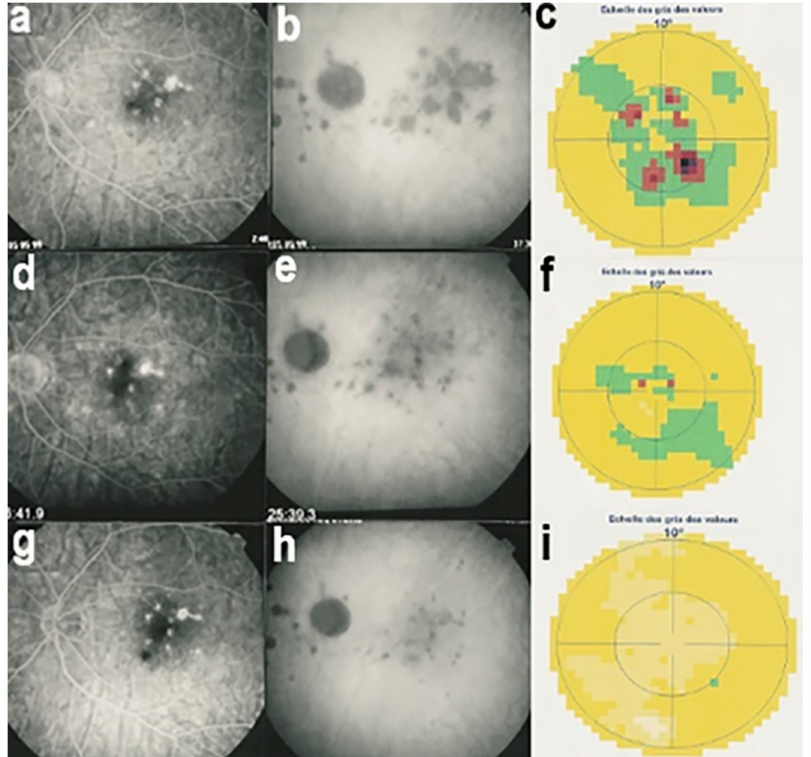
Figure 17. Correlation between FA, ICGA, and visual field during corticosteroid treatment of MFC. This myopic patient presented with left eye photopsias, left decrease of visual acuity (VA) and the presence of a subjective left scotoma. FA ( a ) only shows cicatricial FA lesions corresponding to cicatricial fundus lesions seen on fundus examination. ICGA ( b ) shows widespread hypofluorescent areas, indicating fresh choriocapillaris lesions with corresponding visual field defects ( c ). During corticosteroid therapy, practically no change is seen on FA ( d , g ), whereas ICGA signs of active disease progressively resolve ( e , h ) together with visual field improvement ( f , i